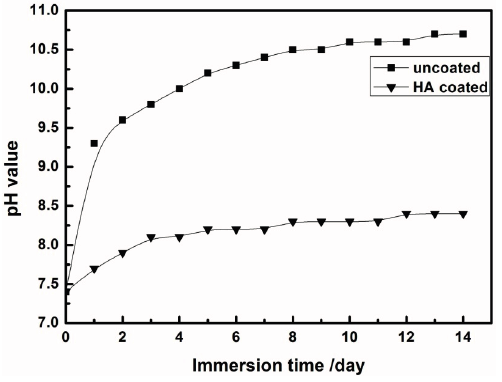
Figure 5. Variation of pH value of immersion solution at different immersion time of uncoated and nHA coated ZK60 samples.